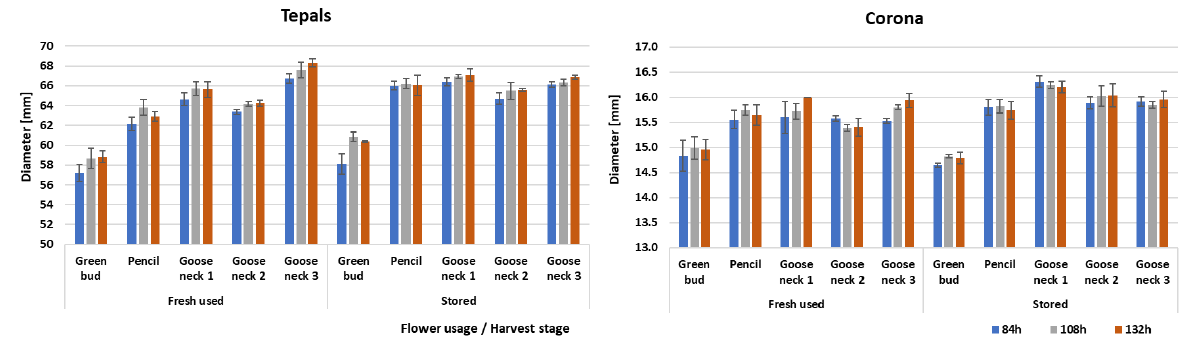
Figure 11. Flower diameter at 84, 108, and 132 h after placing in the vase. Bud stages: green bud (GB); pencil: white bud, upright (PE); goose neck 1: white bud, skew (GN1); goose neck 2: white bud, horizontal (GN2); goose neck 3: big white bud, horizontal, maximum with 1 opening petal (GN3).